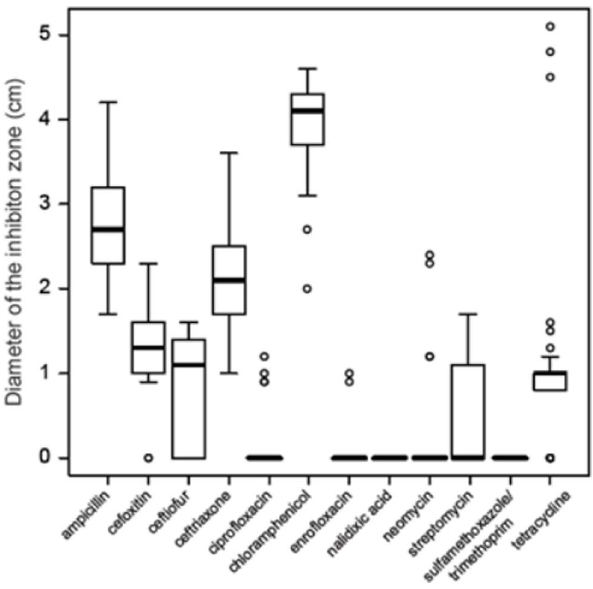
Fig. 7. Box-and-whisker plots depicting the diameter of the inhibition zone measured for each antibimicrobial agent, as determined by the disk diffusion agar